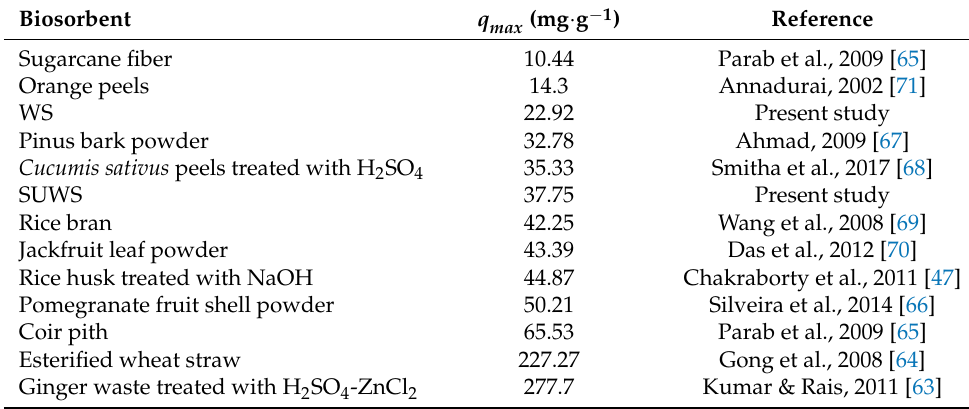
Table 8. Comparison of different low-cost biosorbents for the CV dye